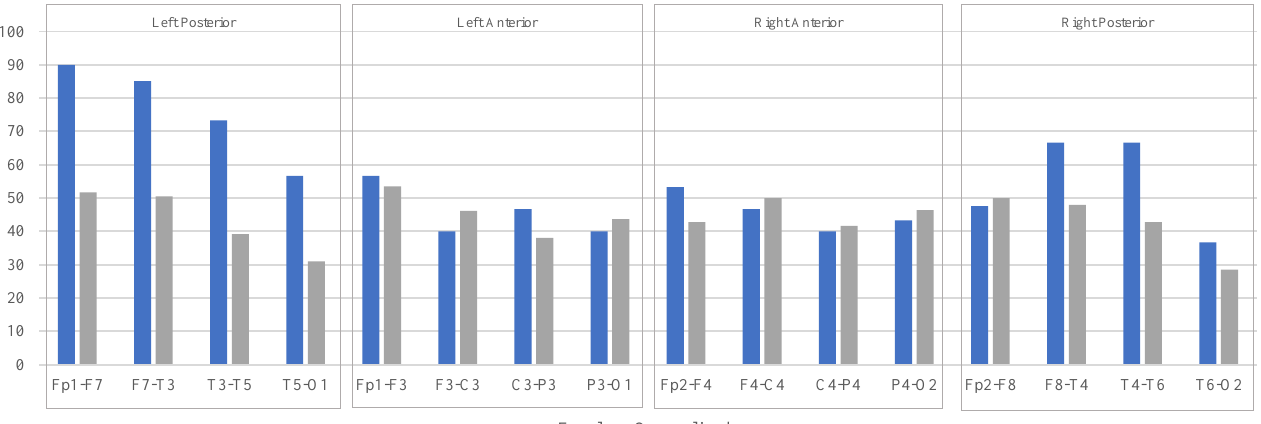
Figure 7. The result of the classification model for focal (blue) and generalized (grey) groups in classifying each channel as affected channels. The X-axis represents LB channels categorized in the left and right posterior and anterior areas. The Y-axis represents the percentage of affected channels according to the population of each group.